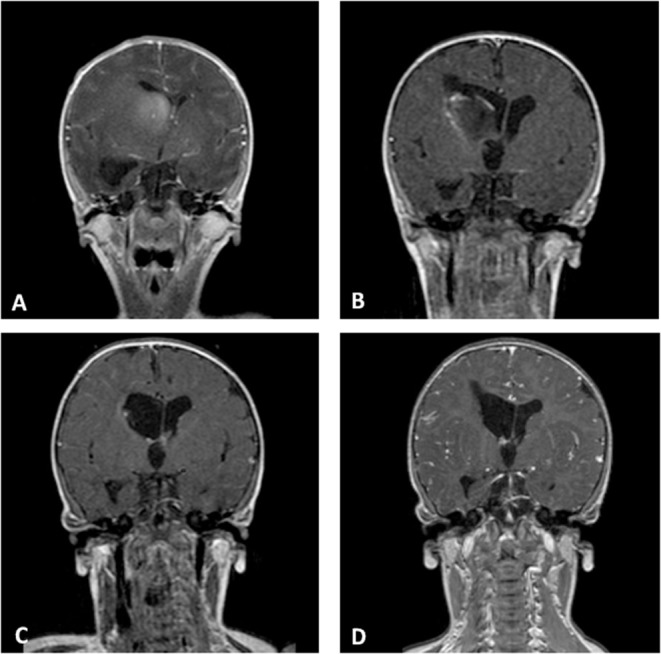
Coronal Gd-enhanced T1-weighted MR scans of a CNS embryonal tumor NOS. (A) Preoperative images demonstrating the intraventricular tumor at the right caudate nucleus. (B) Postoperative scans after septostomy and biopsy of the lesion. (C) Complete response after high-dose chemotherapy and ASCT. (D) Last MR follow-up.